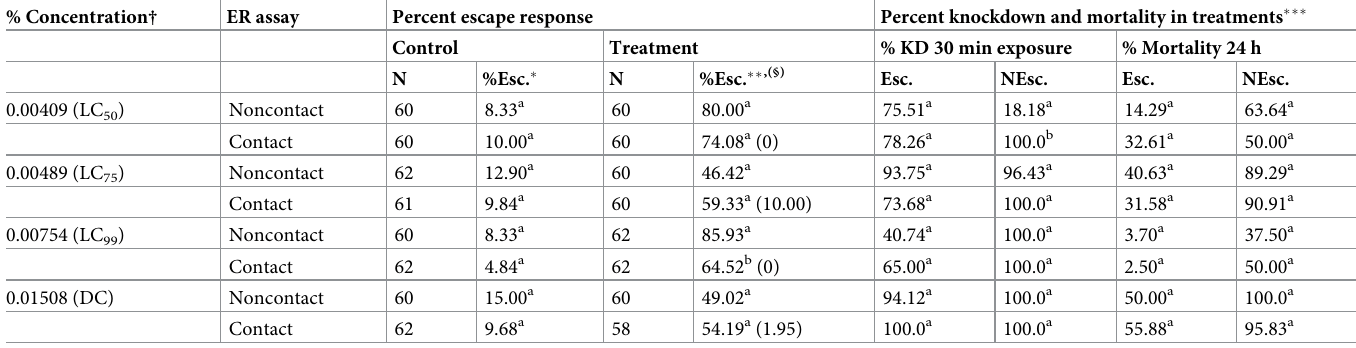
Each test trial consisted of four identical ER chambers as described previously [41]. For mea- suring spatial repellency, a pair of noncontact chambers, one containing TFT treated papers Table 3. Mean percent escape response and percent mortality of An . dirus (TMMU) exposed to TFT in ER assays.